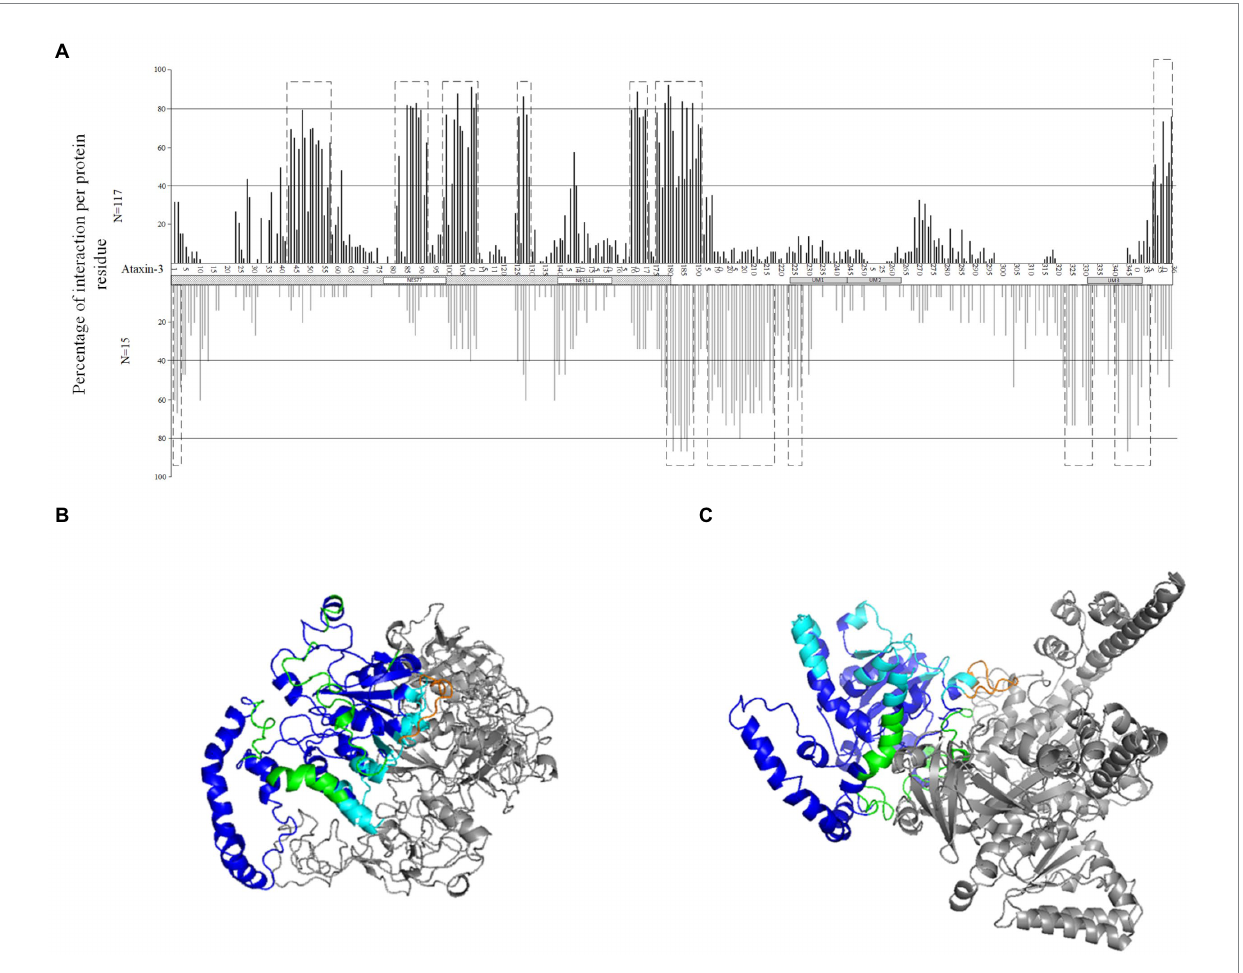
FIGURE 2 Percentage of interaction per protein residue at the ataxin-3 (A) , for the proteins that show most of the interactions at the JD (upper panel, in black) and those that interact mostly at the C- terminal region (lower panel, in gray). Dotted boxes represent regions of interaction where more than 50 percent of the proteins show interaction with ataxin-3. The Josephin domain (JD) is assigned as a dotted box, while the NES77 and NES141 regions are marked with white boxes. UIM regions are also assigned with gray boxes. The dotted boxes ataxin-3 interaction regions are shown on top of the predicted docking structure of ataxin-3 (in dark blue) when interacting with UBC (Gene ID 7316; in gray) that interacts mostly at the JD (B) , as well as on top of the predicted docking structure of ataxin-3 (in dark blue) when interacting with VCP (Gene ID 7415; in gray) (C) that interacts mostly at the C-terminal region. The interaction regions that show most of the interactions at the JD are marked in light blue and those of the proteins that show most of the interactions at the C- terminal region are in green. In orange is the interaction region in common between the two interaction